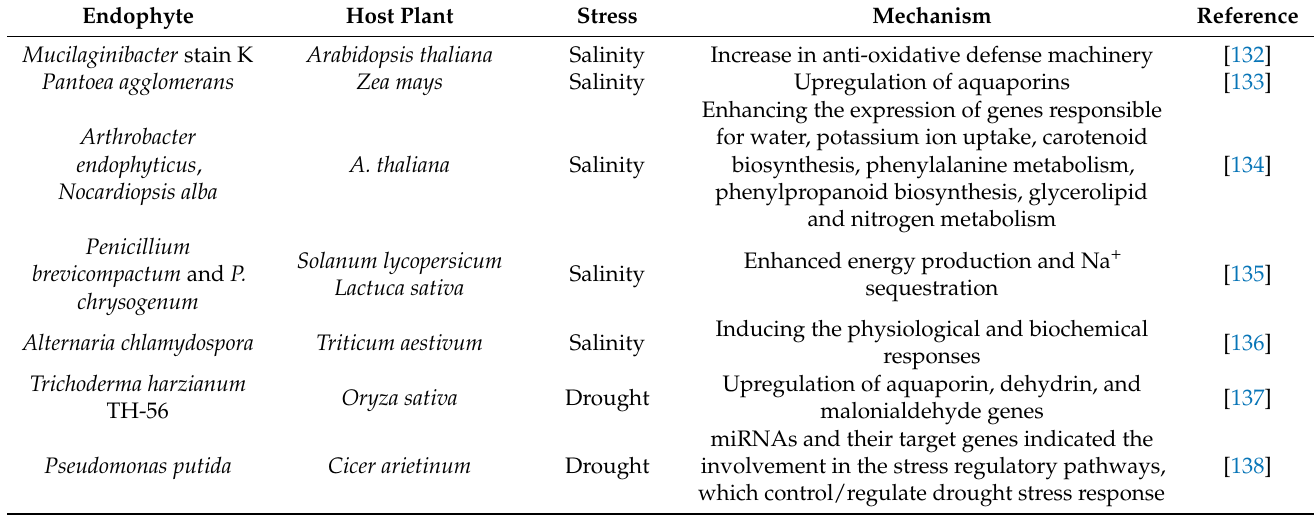
Table 2. List of endophytes mediating abiotic stress tolerance in